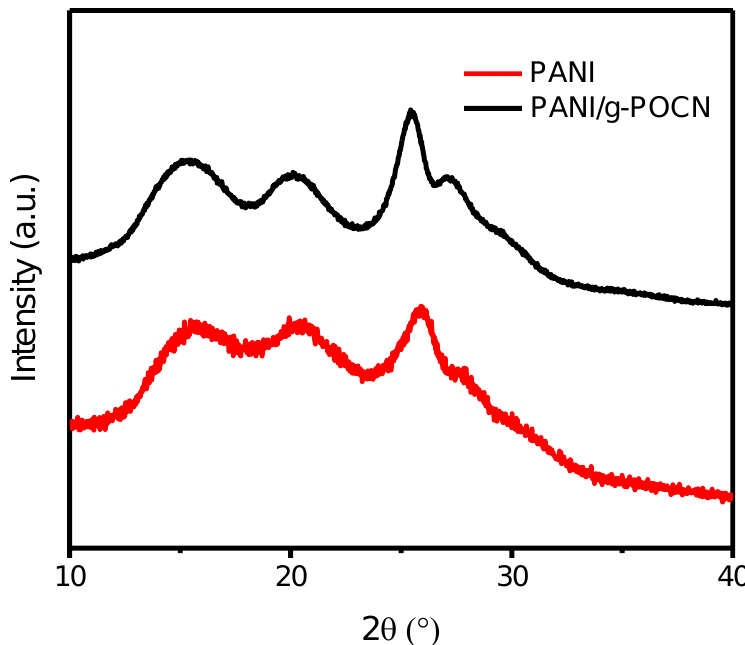
Figure 4. Free PANI and PANI/g-POCN diffractograms. SEM micrographs obtained for PANI/g-OCN, PANI/g-POCN, and Free PANI are